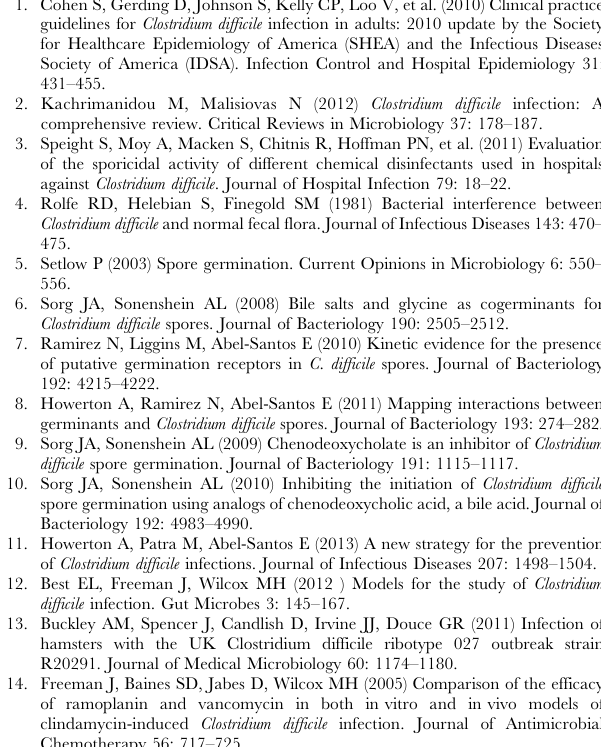
Figure S3 Figure 3. Signs severity for C. difficile infected animals